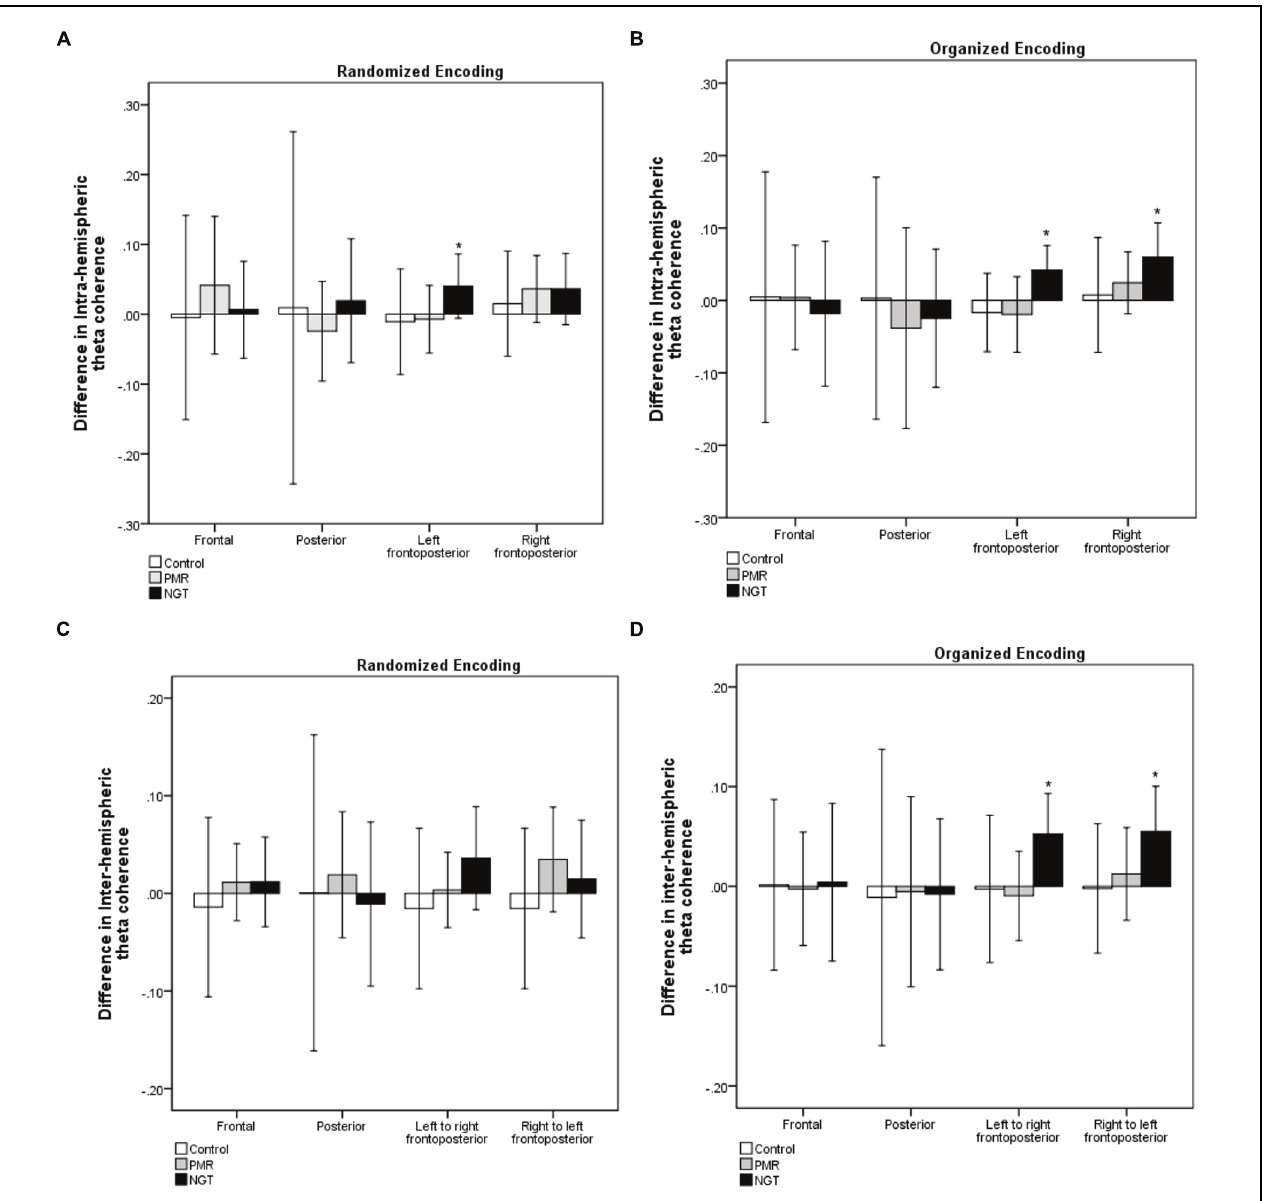
FIGURE 3 | Changes in (A,B) intra-hemispheric and (C,D) inter-hemispheric theta coherence after 1 month in the three groups in the randomized and organized conditions. Positive values indicate increased theta coherence. The error bars represent 95% confidence interval of the difference between pre- and post-training theta coherence values. Control, control group without training; PMR, progressive muscle relaxation; NGT, Nei Gong training. ∗ p < 0.05 (paired samples t-